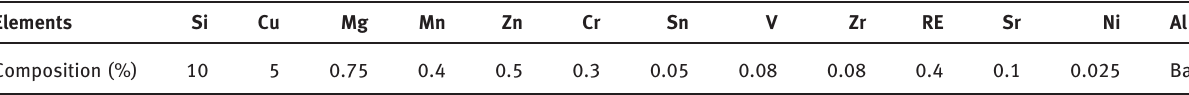
Table 1: Chemical composition of the alloy. Elements